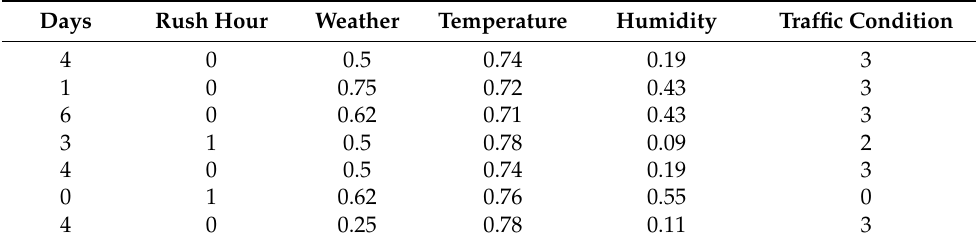
Table 18. The dataset collection result for AhmadYani-Supratman road